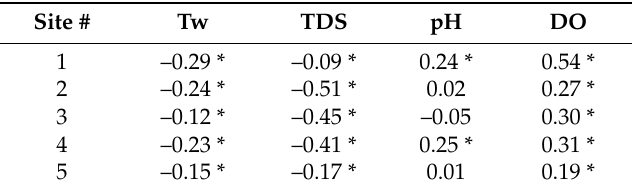
Figure 7. Box and whisker plot of dissolved oxygen (% of saturation) at each gauging site ( n = 5) during study period (October 2010–May 2014) in Hinkson Creek Watershed, MO, USA. Boxes delineate 25–75 percentiles. Whiskers delineate standard deviation. Squares within boxes indicate means, lines show medians. X’s indicate 99th percentile when above, 1 st when below. Minus symbols indicate maximum when above, minimum when below.